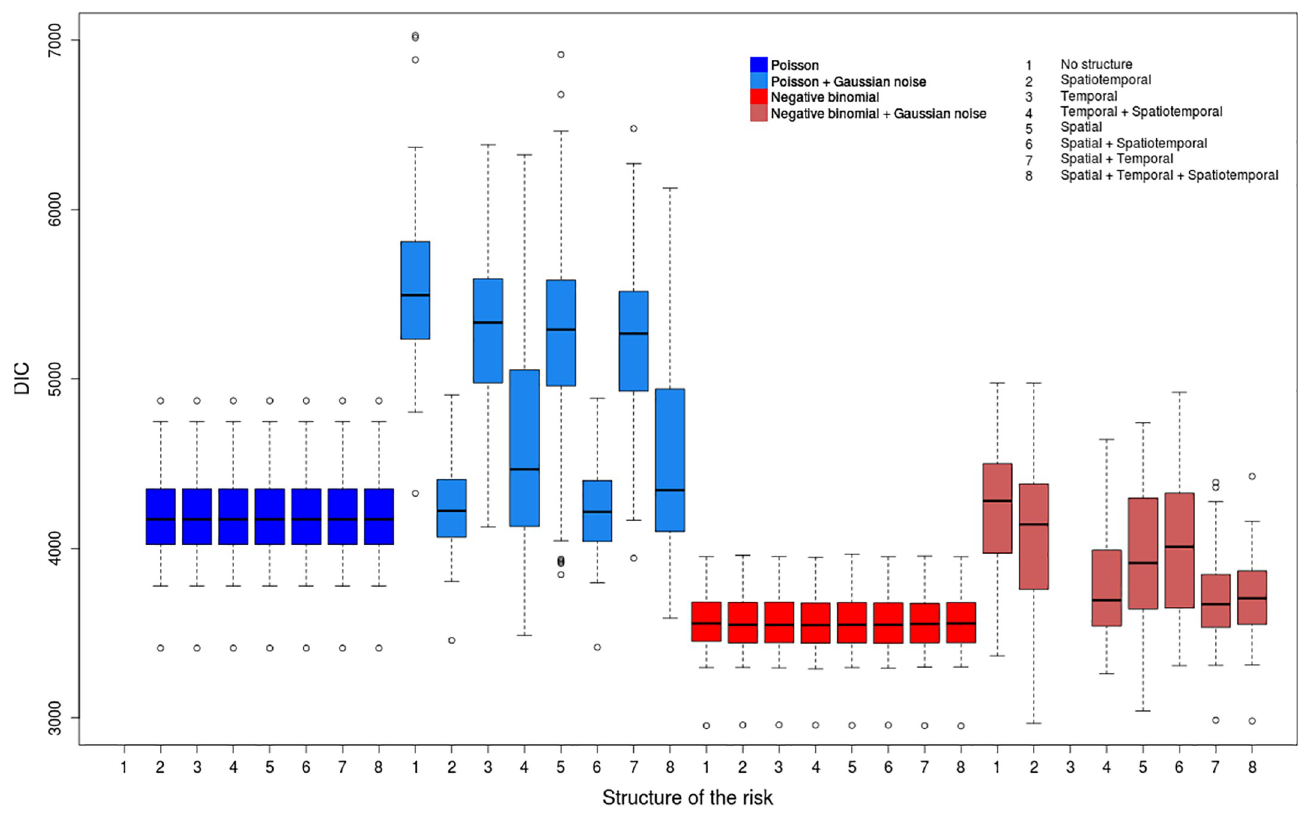
Fig 4. Distribution of DIC values for the scenario